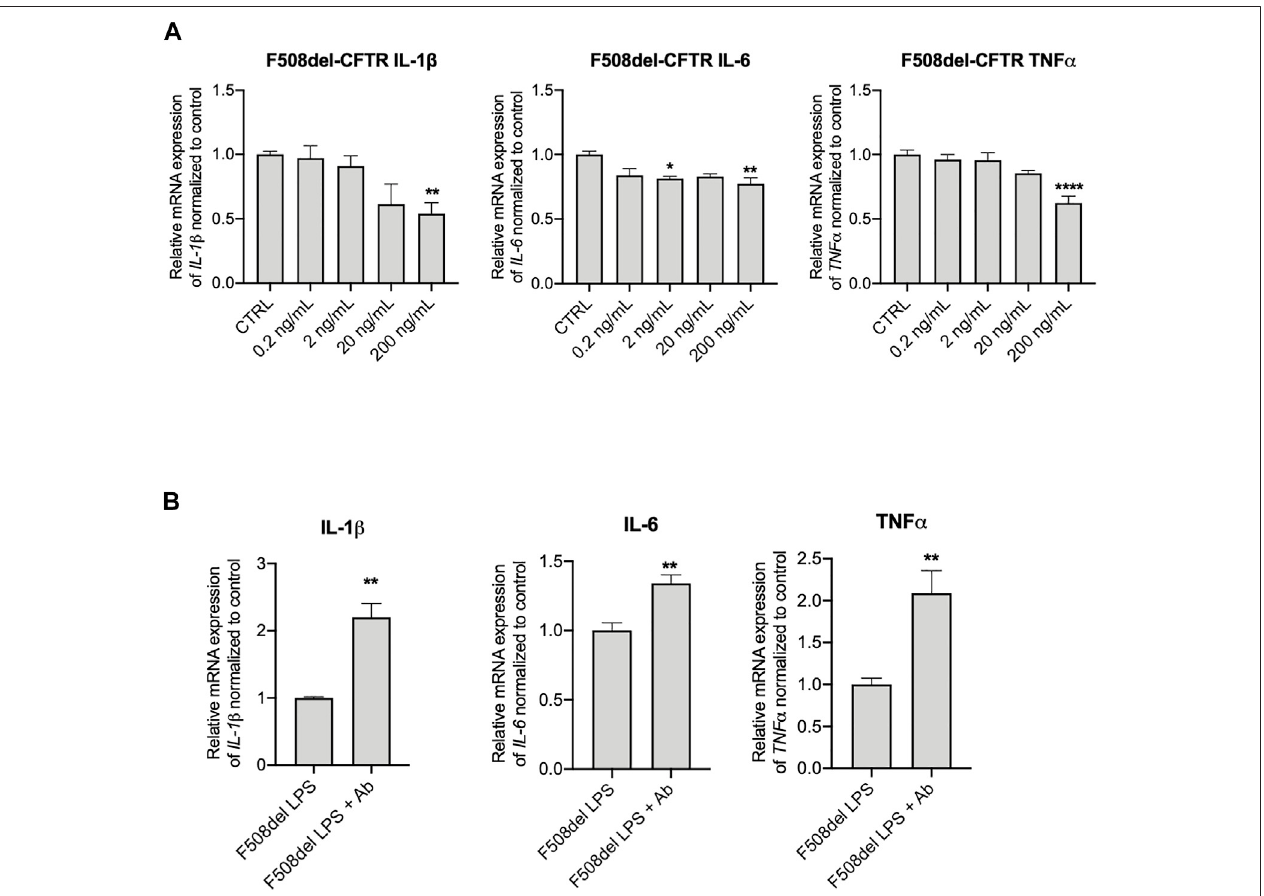
FIGURE 3 | Anti-IGFBP-6 antibodies increased pro-in fl ammatory cytokines expression. (A) F508del-CFTR CFBE cells were treated with PBS or 0.2 – 200 ng/ml IGFBP-6 for 4 h. Statistical signi fi cance tested using two-way ANOVA with Tukey ’ s multiple comparisons test. (B) Cells were treated with 1 μ g/ml LPS ± an antibody directed against IGFBP-6 (1 μ g/ml) for 4 h. Total RNA was extracted and qRT-PCR was performed in order to quantify IL-1 β , IL-6 and TNF- α mRNAs normalized to GADPH as housekeeping gene and then to control untreated cells. Data represent the mean ± SEM ( n = 3). Statistical signi fi cance tested using paired two-tailed t